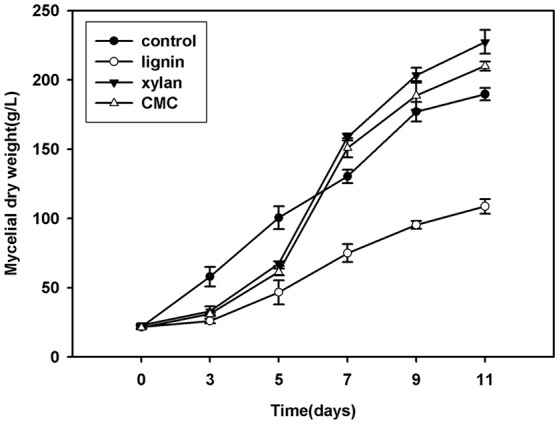
Growth curve of mycelium (mycelium dry weight) in Krik's, lignin, cellulose, and xylan for 11 days.